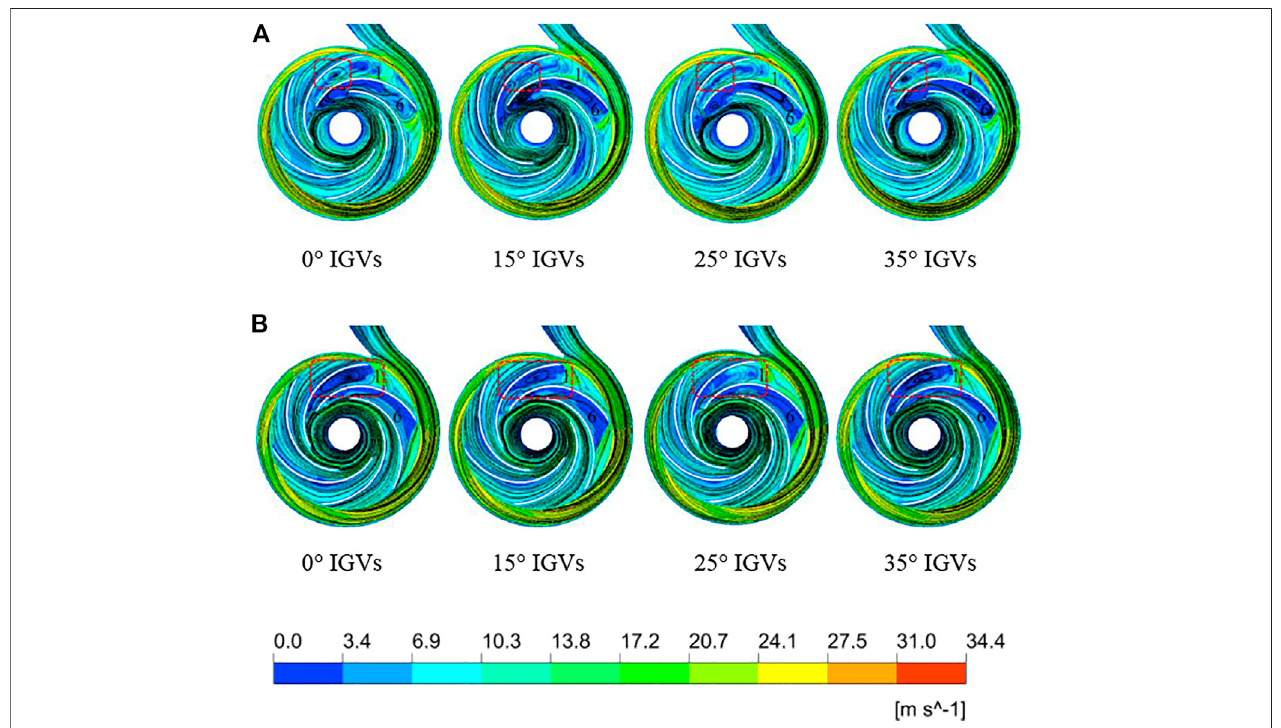
FIGURE 6 | Streamlines of relative velocity at the cross-section: (A) 0.6 Q d and (B) 0.8 Q d .